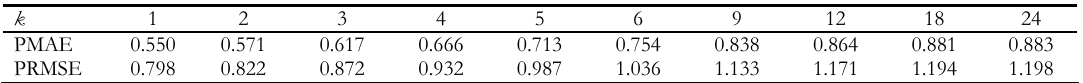
Predictive mean absolute error (PMAE) and predictive root mean square error (PRMSE) computed between the actual values and the k-hour ahead